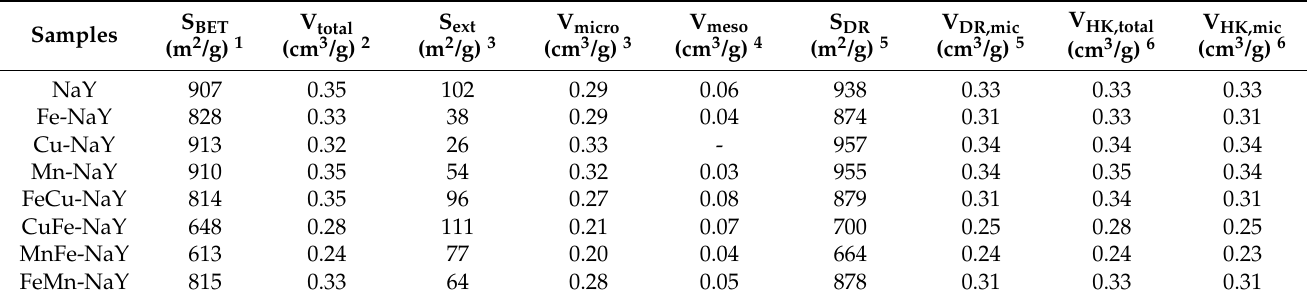
Table 2. Textural properties of the parent NaY and of the supported metal catalysts.